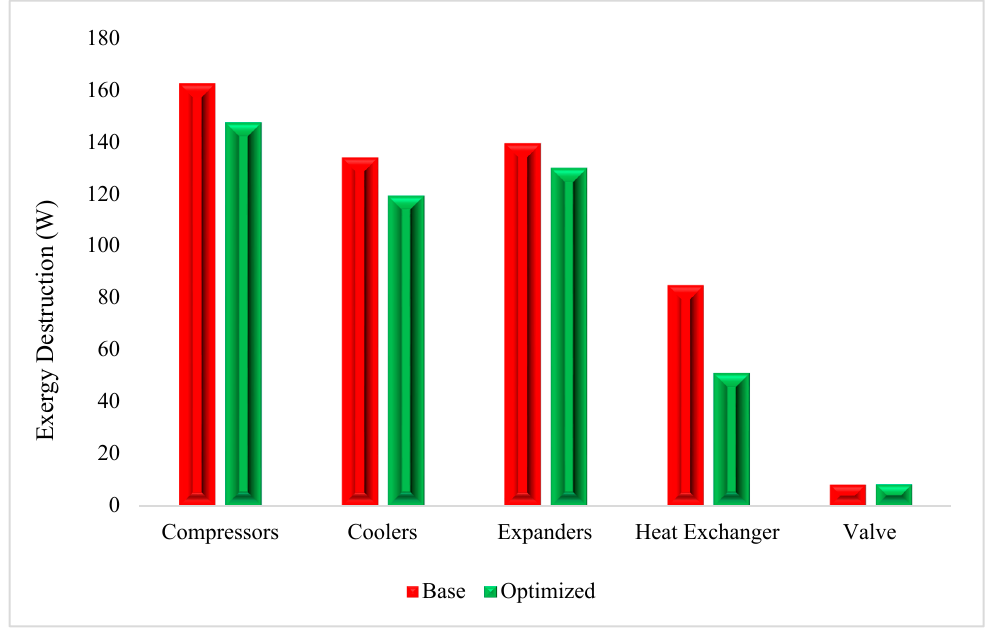
Figure 8. Exergy destruction comparison in N 2 dual expander LNG process (base and optimized cases).